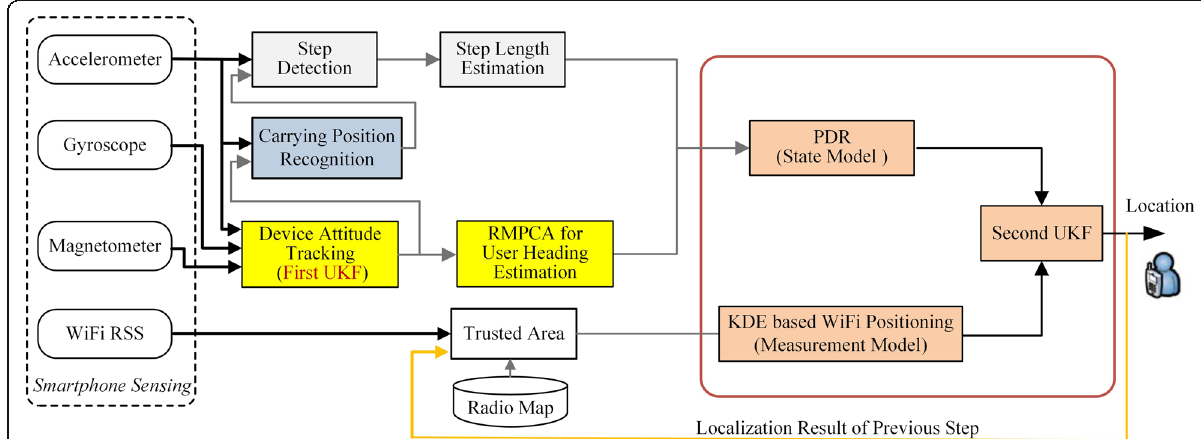
Fig. 1 Overview of the proposed UKF-based integrated localization